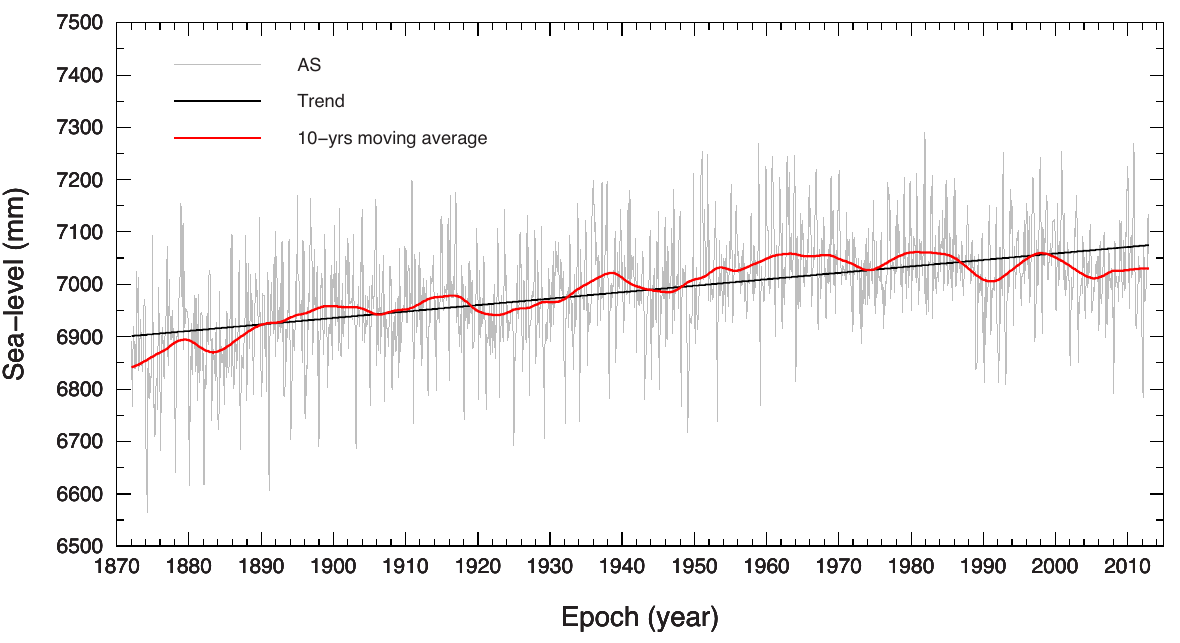
Figure 2. Stack of the Adriatic tide series from monthly data (AS curve). The black and the red curves show the best–fitting linear trend and the 10–years rolling average, respectively.